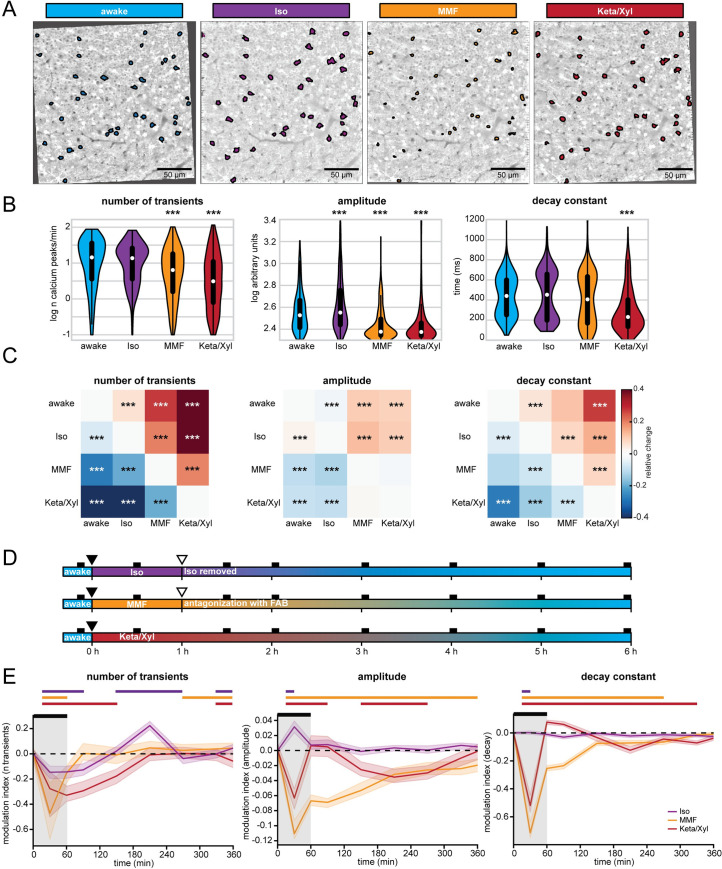
Calcium activity profiles in neurons active during all conditions are similar between wakefulness and Iso.(A) Two-photon time-averaged images of the same FOV in CA1, aligned to the Iso condition (same images as in Fig 3). ROIs show neurons active in each condition, allowing direct comparison of calcium transients in the same cells under different conditions. (B) Violin plots quantifying the number (left), amplitude (middle), and decay (right) of detected calcium transients. White dots indicate median, and vertical thick and thin lines indicate first to third quartile and interquartile range, respectively. (C) Heat maps displaying the relative change in the number (left), amplitude (middle), and decay (right) of calcium transients between neurons active in pairs of conditions (see also S6C Fig). (D) Schematic representation of long-term calcium imaging experiments to assess recovery from anesthesia. Black rectangles indicate imaging time points (up to 10 minutes duration each). Filled and open triangles indicate the start and end of the anesthesia period. (E) Line diagrams showing the relative change of the median number of calcium transients (left), their amplitude (middle), and decay constant (right) during anesthesia and recovery relative to the awake state before anesthesia induction. The black bar indicates the anesthesia period. Shaded, colored lines indicate 95% confidence interval. Note, Keta/Xyl anesthesia could not be terminated. The horizontal, colored lines indicate significant difference (p < 0.05) to awake time point (t = 0) for the respective condition. Asterisks in (B) and (C) indicate significant differences to wakefulness. *** p < 0.001. Note, to facilitate readability, only differences to wakefulness are indicated. For full report of statistics, see S1 Table. All datasets of this figure can be found under https://github.com/mchini/Yang_Chini_et_al/tree/master/Stats_Dataset_(R)/datasets/Figure4_S6. FOV, field of view; Iso, isoflurane; Keta/Xyl, ketamine/xylazine; MMF, medetomidine/midazolam/fentanyl; ROI, region of interest.